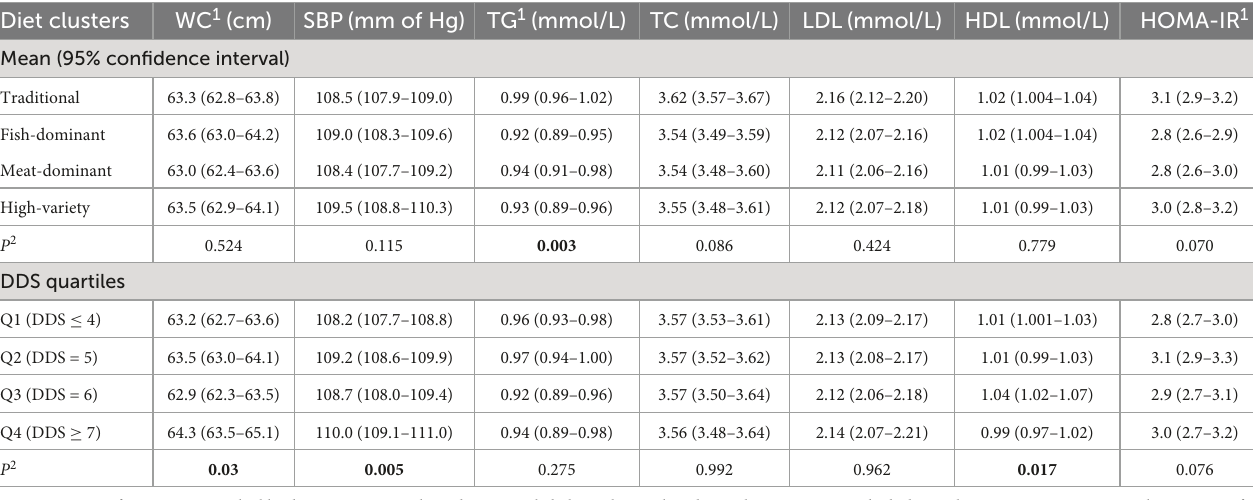
TABLE 3 Levels of cardiometabolic risk markers by diet clusters and quartiles of dietary diversity score. Diet